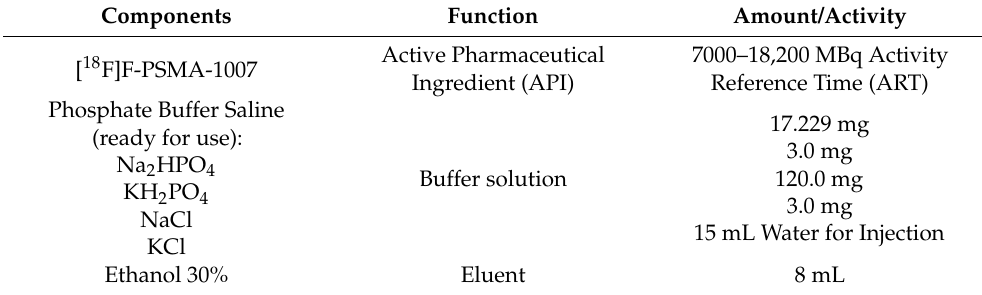
Table 3. Batch formula of [ 18